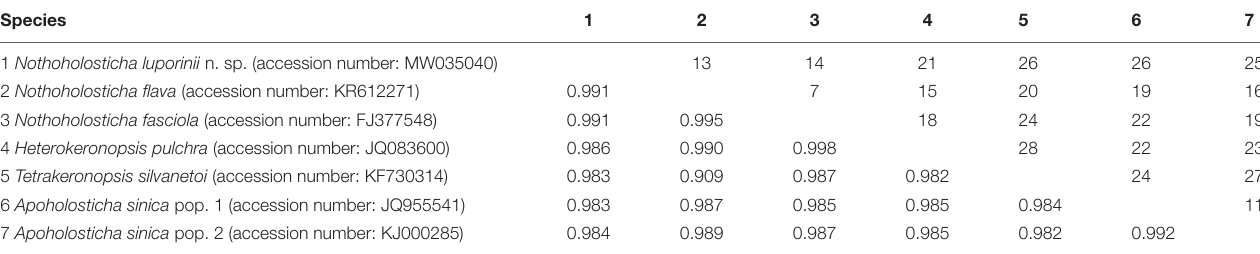
TABLE 2 | Numbers of unmatched nucleotides (above diagonal) and pairwise similarities (below diagonal) of SSU rDNA sequences among members of the subfamily Nothoholostichinae.